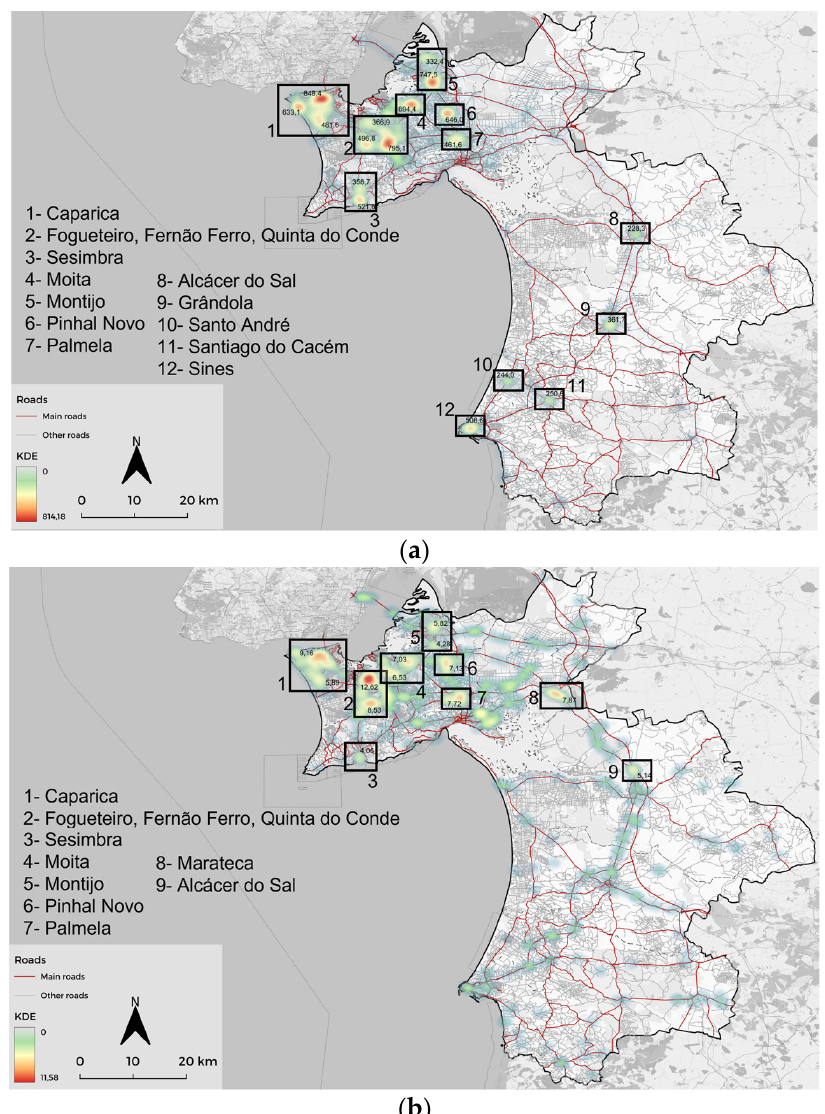
Figure 2. KDE maps for datasets I (all accidents) and II (accidents with serious or fatal victims). ( a ) KDE map with the high-density regions (HDR) outlined for dataset I. ( b ) KDE map with the HDR outlined for dataset II. The numbers inside each hotspot region indicate the maximum value for each HDR.